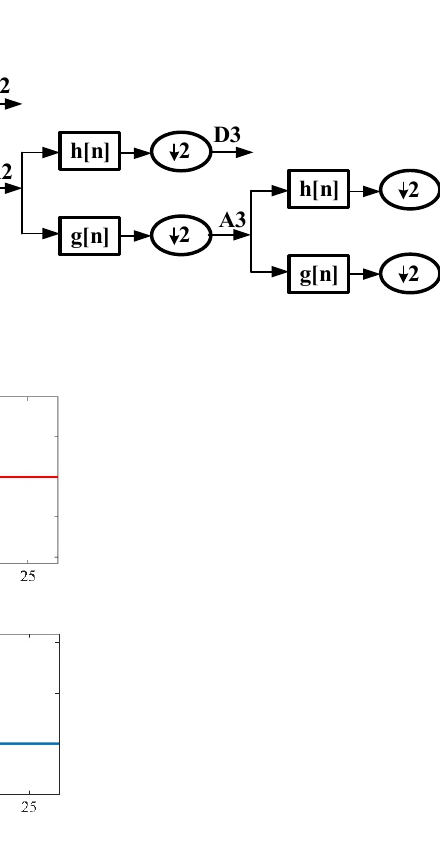
Figure 5. Sym7 mother wavelet and scaling function.